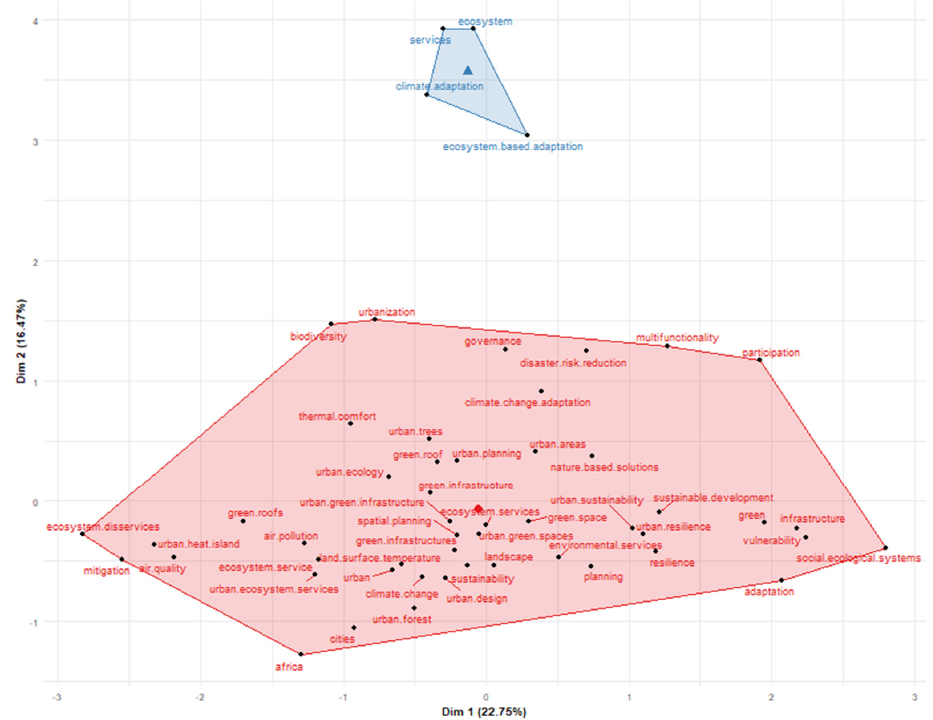
Figure 14. Conceptual Structure Map by Author Keywords. Source: Biblioshiny. Own compilation.